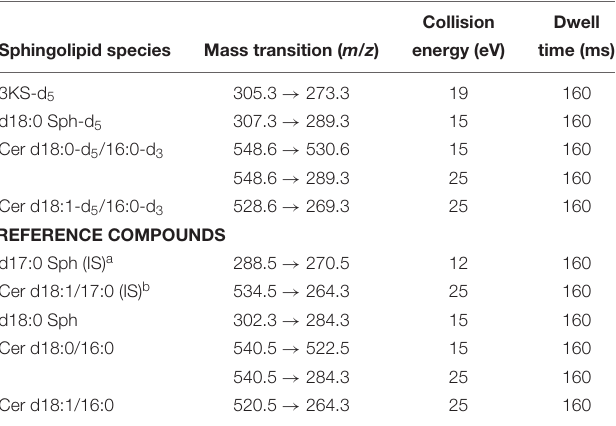
TABLE 2 | MS/MS parameters for detection of de novo formed sphingolipids using the TQ MS system.